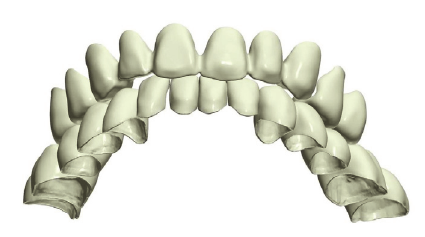
Figure 4: Intraoral digital scan of the preparations of both dental arches.